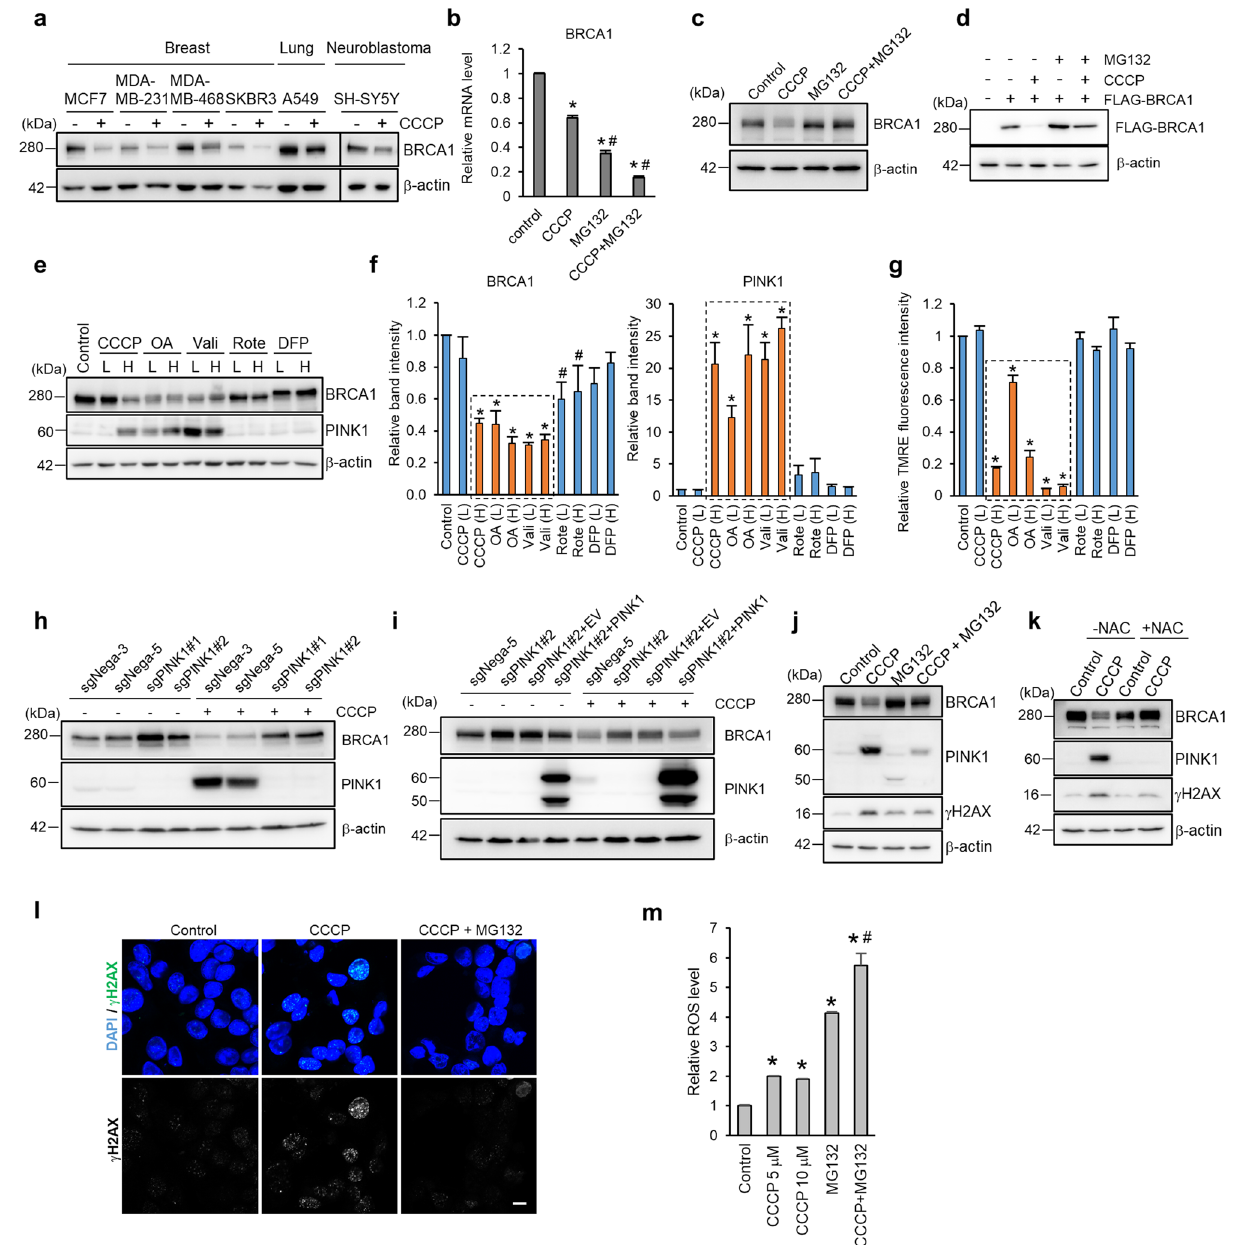
Figure 1. Mitochondrial damage promotes PINK1-dependent BRCA1 degradation. ( a ) Western blotting analysis of BRCA1 in indicated cell lines treated with or without 10 μM CCCP for 24 h. ( b ) BRCA1 mRNA expression level was assessed after treatment with CCCP ± 10 μM MG132 for 24 h. n = 3, bar = means ± S.E., * p < 0.01 versus control, # p < 0.01 versus CCCP. ( c ) MCF7 cells were treated with the indicated agents for 24 h and BRCA1 protein level was assessed. ( d ) 293 T cells were transfected with FLAG-tagged BRCA1 and treated with the indicated agents for 24 h. ( e ) MCF7 cells were treated with CCCP (2 or 10 μM), oligomycin A and antimycin A (OA) (0.5 μM + 50 nM or 2.5 μM + 250 nM), valinomycin (Vali) (0.5 or 2 μM), rotenone (Rote) (0.5 or 2 μM), or DFP (0.2 or 1 mM) for 24 h. L and H respectively indicate low- and high-dose treatments. ( f ) The calculated band intensities of BRCA1 and PINK1 were shown. Bar = means ± S.E., n = 3. * p < 0.01, # p < 0.05 versus control. ( g ) Mitochondrial membrane potential was measured. Bar = means ± S.E., n = 3, * p < 0.05 versus control. ( h ) PINK1 knockout MCF7 cells or control cells were treated with ± 10 μM CCCP for 24 h. ( i ) BRCA1 expression level in sgPINK1#2 cells expressing PINK1 or empty vector (EV) was assessed after CCCP treatment for 24 h. ( j ) MCF7 cells were treated with the indicated agents for 24 h and assessed DNA double-strand breaks by detecting γH2AX expression. ( k ) MCF7 cells were treated with CCCP ± 10 mM NAC. ( l ) Immunostaining of γH2AX in MCF7 cells treated with the indicated agents. Nuclei were stained with DAPI. γH2AX signals and nuclei are shown as green and blue, respectively. Scale bar = 10 μm. ( m ) ROS levels were assessed in MCF7 cells treated with the indicated agents for 24 h. n = 3, bar = means ± S.D. * p < 0.05 versus control. # p < 0.05 versus